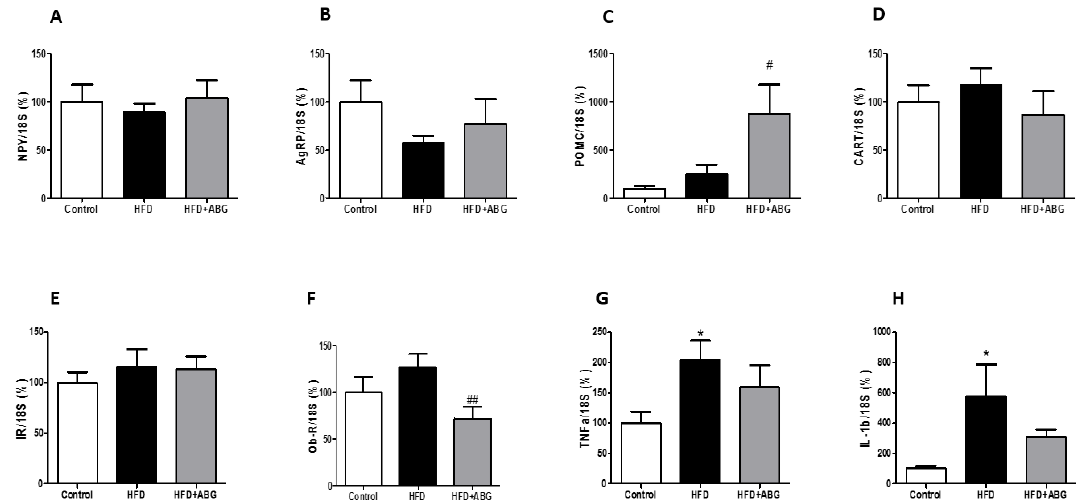
Figure 4. mRNA concentrations of neuropeptide Y ( A ), agouti-related protein ( B ), proopiomelanocortin ( C ), cocaine and amphetamine related transcript ( D ), insulin receptor ( E ), leptin receptor ( F ), TNF- α ( G ) and IL-1 β ( H ) in the hypothalamus of rats fed a standard chow (control) or a high-fat diet (HFD)/high-sucrose diet and treated with vehicles or HFD + ABG. Data are represented as mean ± SEM; n = 8 samples/group. * p < 0.05 vs. control; # p < 0.05 vs. HFD; ## p < 0.01 vs. HFD.